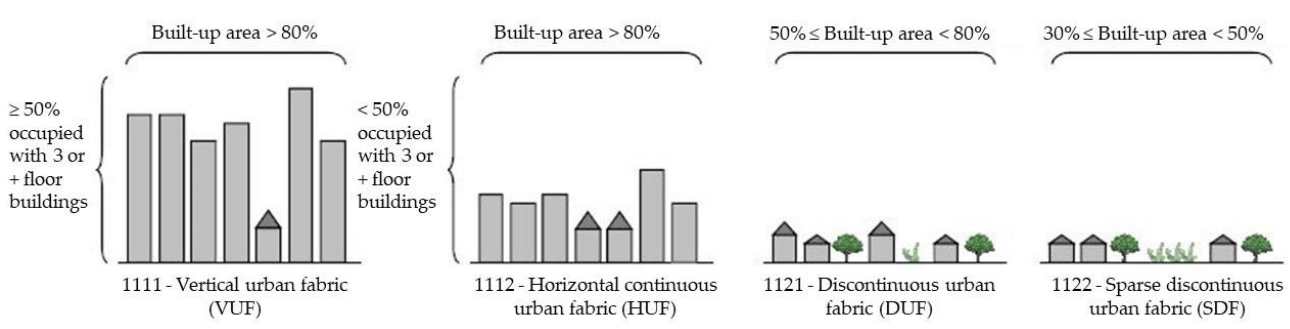
Figure A1. Main urban development built-up classes. Source: [32]. Table A1. Developed land use land cover (LULC) classes and average structure density values in Portugal [32]. The density values were calculated for each polygon based on the national residential building dataset (1), derived from a sample of 18 sites (one per district) (2); or attributed as industrial (3) or isolated buildings